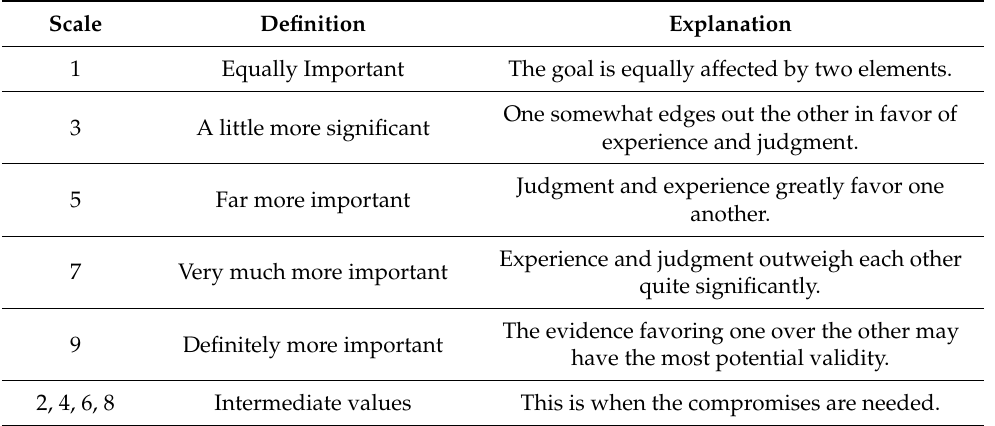
Table 2. The scale of weightage for AHP given by Saaty [63].